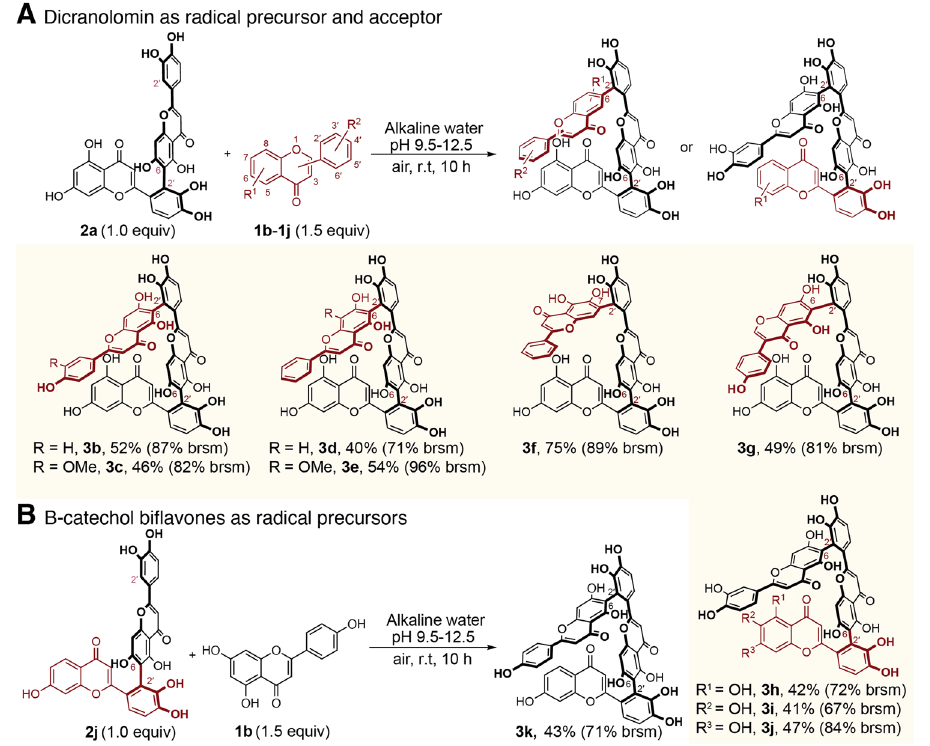
Fig. 5 | The substrate scope of oxidative coupling for the synthesis of tri fl avonesinalkalinewater.A Dicranolominasaradicalprecursor and acceptor.